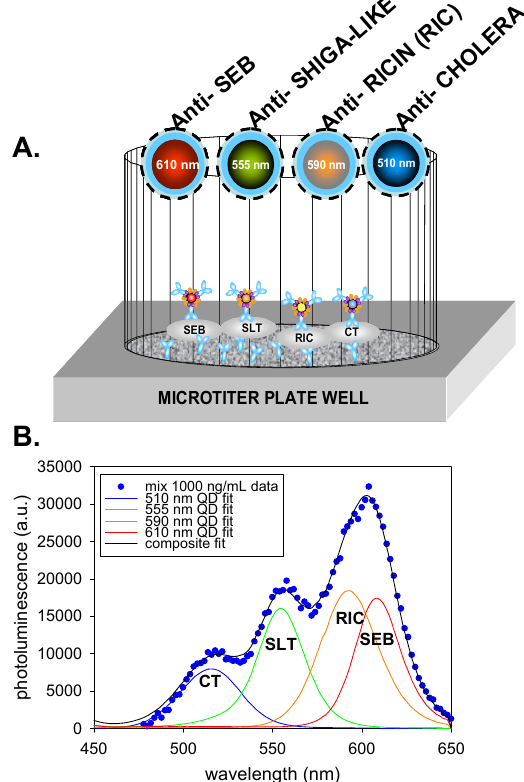
Figure 4. Multiplex Immunoassays with Quantum